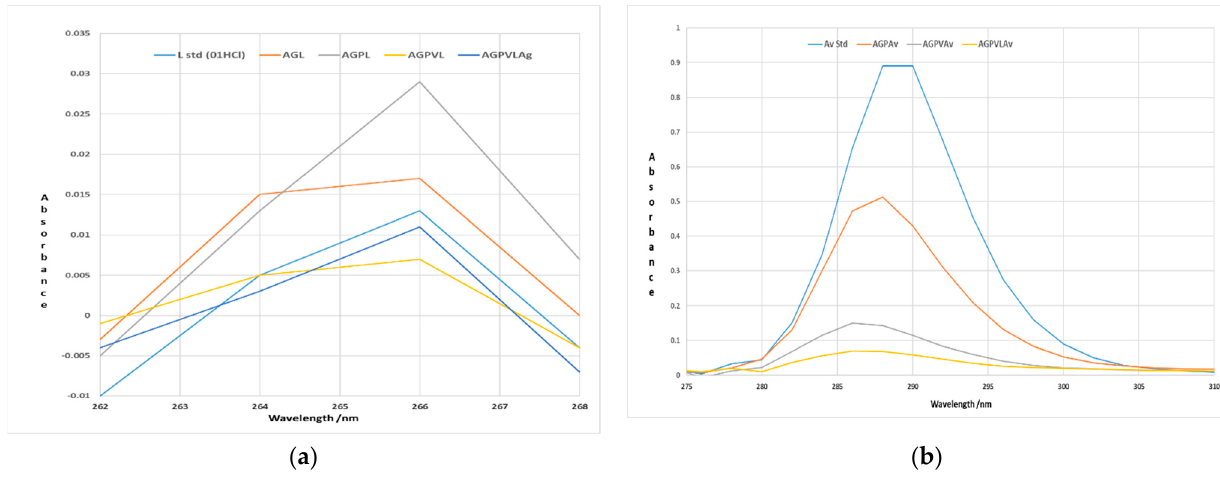
Figure 9. ( a ) Absorbance obtained in the case of membranes compared with the standard of the active substance L ; ( b ) Absorbance obtained in the case of membranes compared with the standard of the active substance Av .